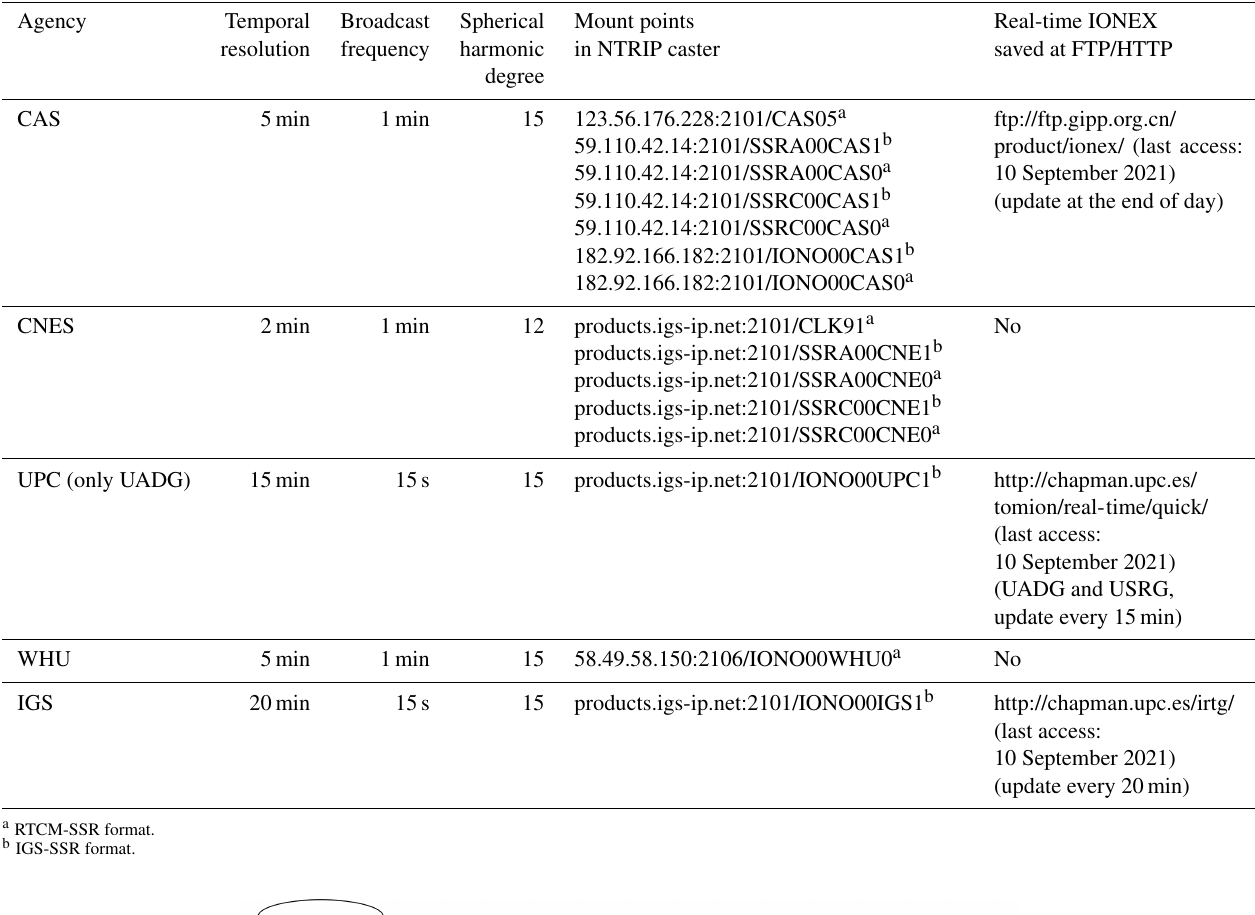
Table 2. The current status of broadcasting IGS RT-GIMs.